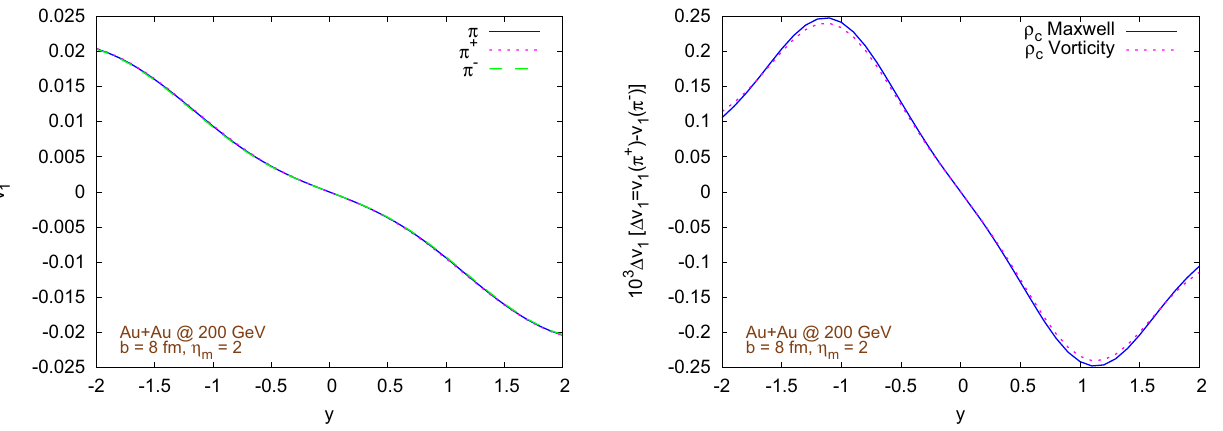
computed by using either the Maxwell equations or the vorticity. Both √ s NN = 200GeV with impact plots refers to Au+Au collisions at parameter b = 8fm and tilted initial energy density distribution with parameter η m = 2